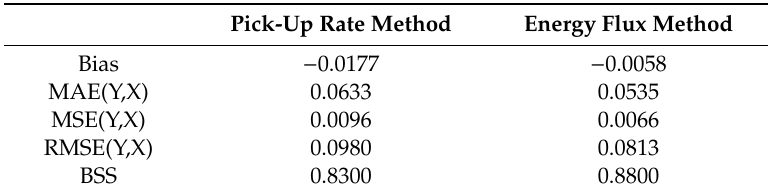
Table 4. Obtained statistical parameters in the area of interest for both the pick-up rate simulation and the energy-flux simulation dataset of 20